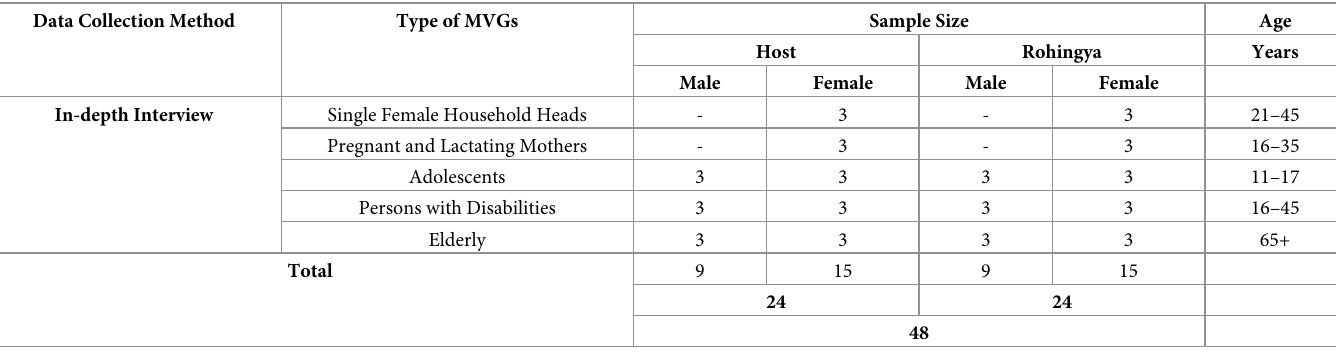
Table 1. Data collection method, study population, and